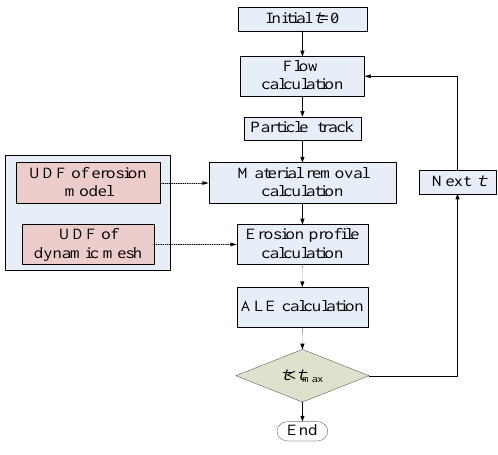
Figure 2. Calculativeprocess of erosion evolution.